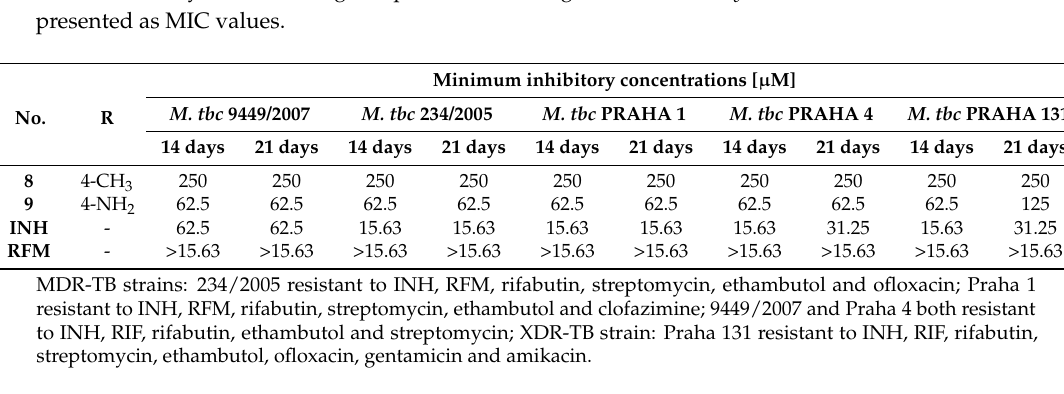
Table 3. Activity of two leading compounds 8 and 9 against resistant Mycobacterium tuberculosis strains presented as MIC